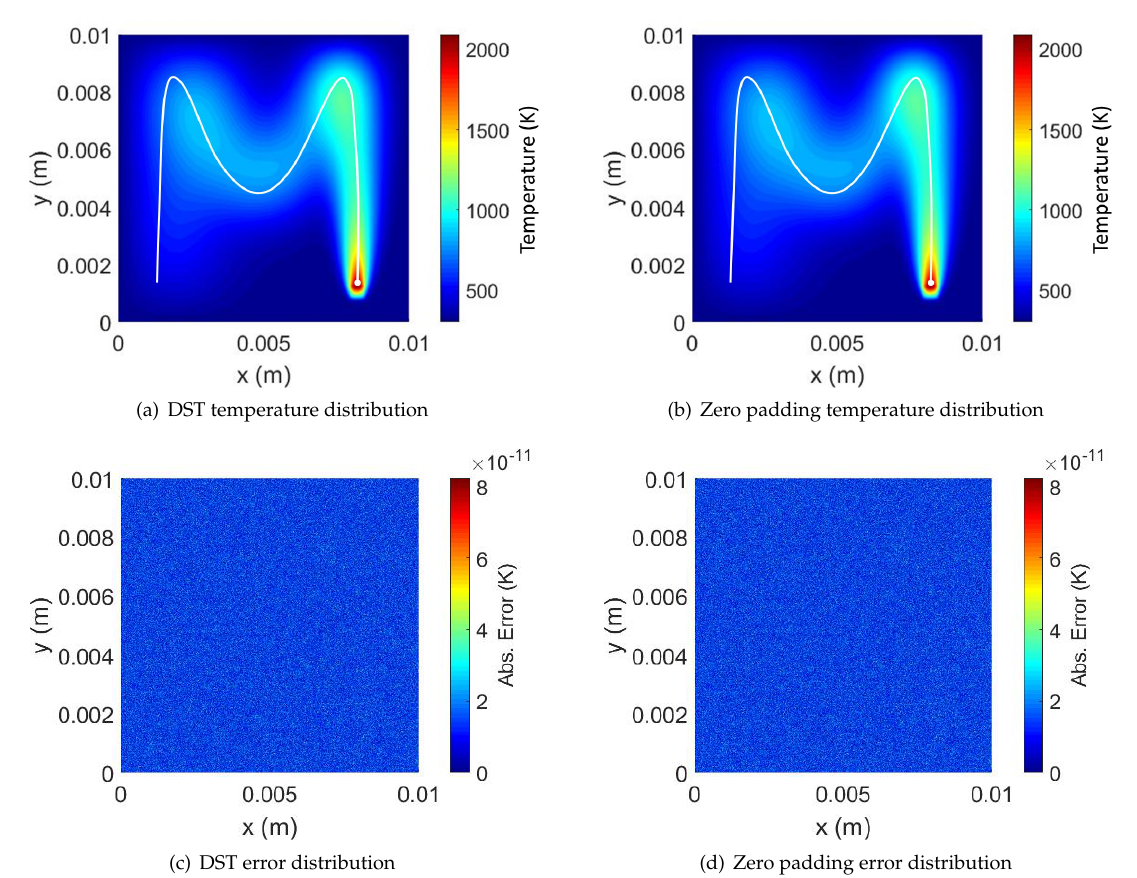
Figure 8. Temperature and absolute error distributions (w.r.t. the brute-force approach [24]) on the thin plates for the DST and the zero padding FFT